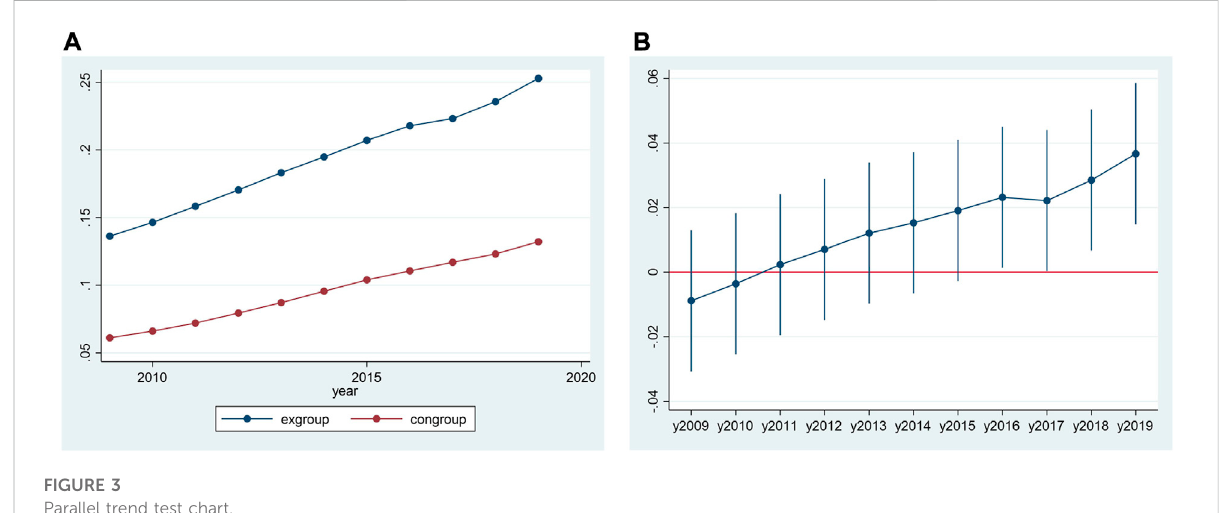
FIGURE 3 Parallel trend test chart.